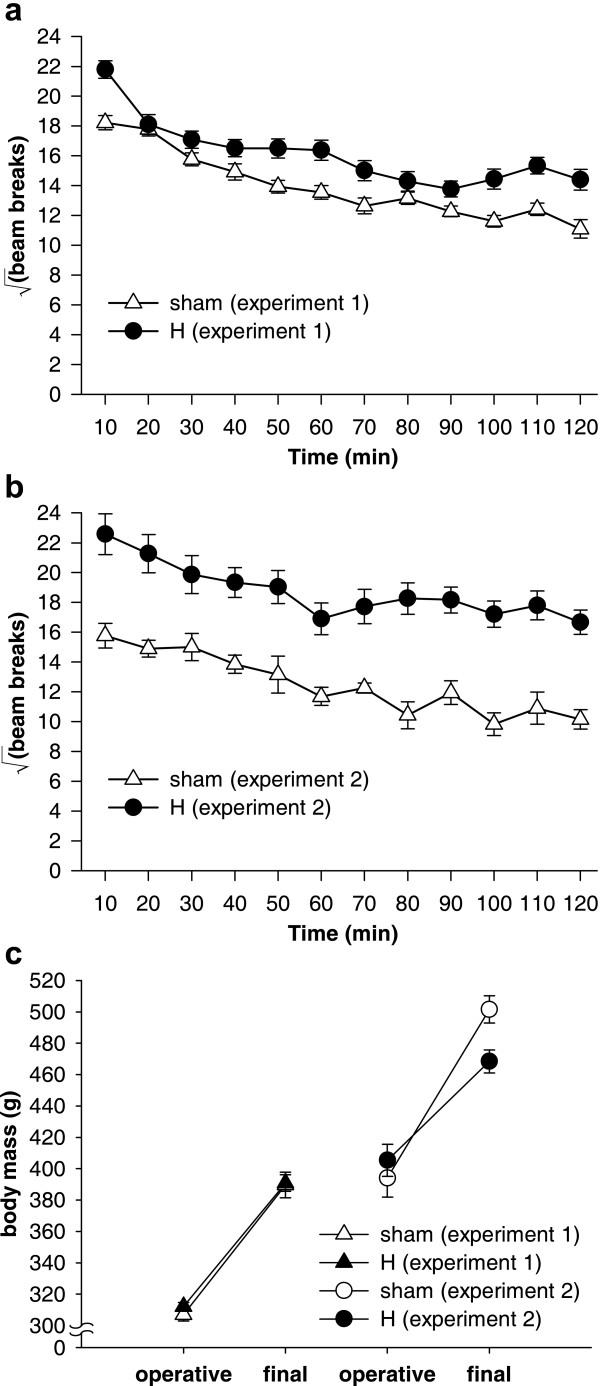
Locomotor activity in a novel environment and body mass. Hippocampal-lesioned rats were significantly hyperactive compared to sham-operated controls, in both (a) Experiment 1 (p = .003) and (b) Experiment 2 (p < .001). (c) Body mass across both experiments. There were no differences between groups preoperatively in either experiment. In Experiment 1, the groups gained weight at the same rate, but in Experiment 2, which lasted longer, the H-lesioned rats weighed less at the end of the experiment (p = .01).